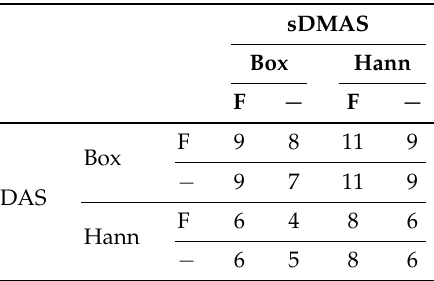
Table 2. CNR of DAS, DMAS and sDMAS in db for µ a = 8.5cm − 1 . CNRs are averaged over n = 100 slices and listed for three signal positions. The CNRs for depths 8mm and 13mm had a standard deviation of ≈ 1db. For the depth of 18mm the standard deviation was ≈ 1.5db. DAS F-DMAS sDMAS Box Hann Box Hann Box Hann